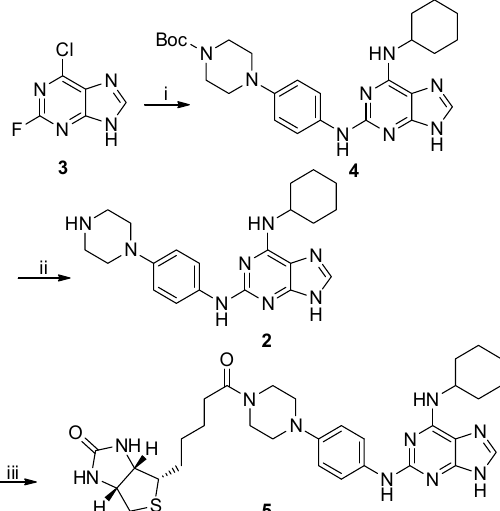
Scheme 1. Synthesis of biotinylated reversine probe. Reagents and conditions: ( i ) (a) cyclohexyla- mine, DIPEA, n-BuOH, 80 °C, 24 h, (b) tert-butyl 4-(4-aminophenyl) piperazine-1-carboxylate, EtOH, 81% yield over two steps; ( ii ) HCl, i-PrOH, 97% yield; ( iii ) biotin, ECDI, DMAP, DMF, 75% yield.